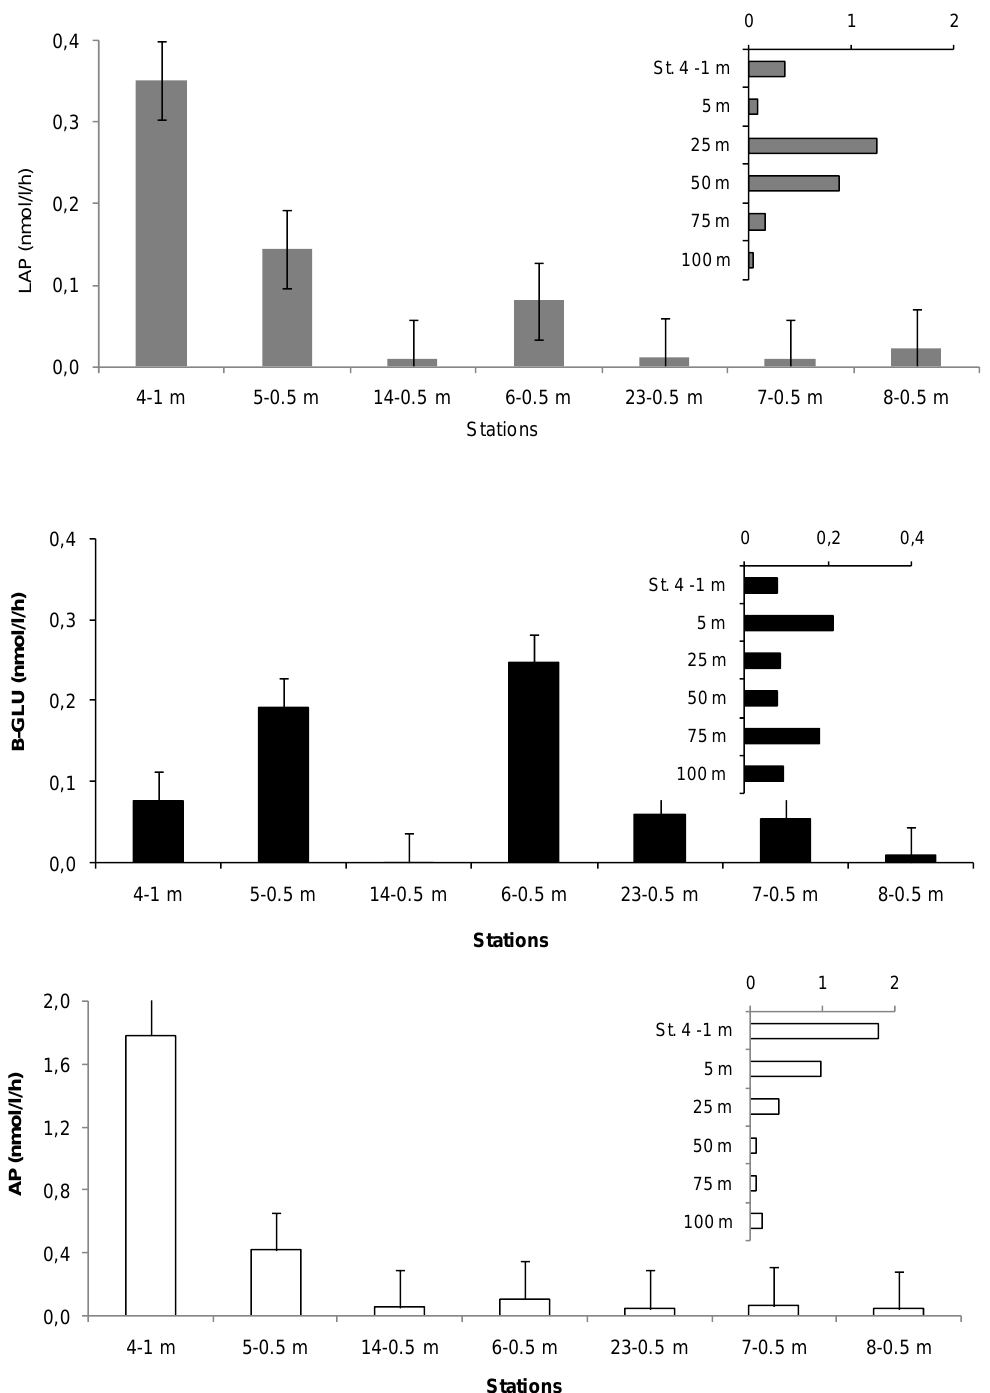
Figure 7. Mean values ± S.E. of enzyme activity rates (LAP, leucine aminopeptidase; GLU, beta-glucosidase; AP, alkaline phosphatase) measured in the Kongsfjorden transect from the entrance to the glacier, and vertical profile of the Station 4 (0 – 100 m).